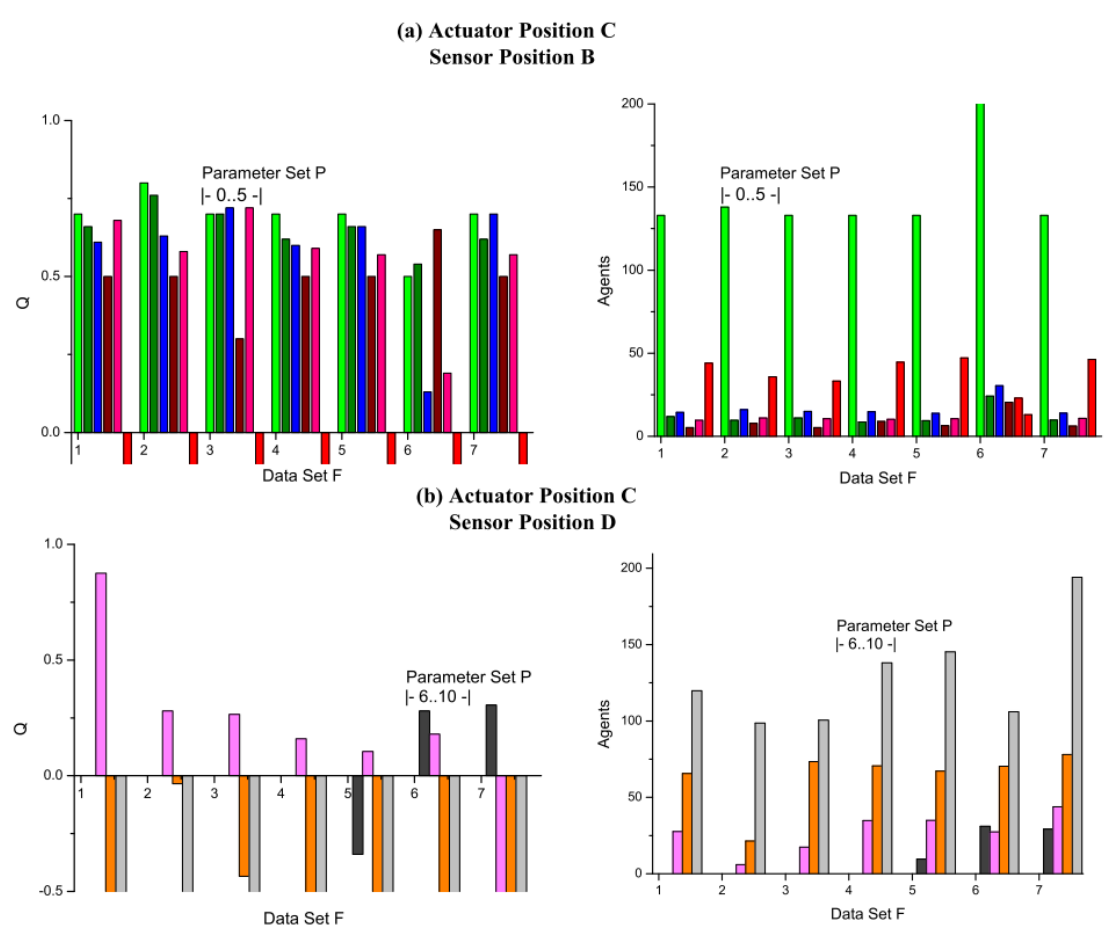
Figure 5. Analysis results showing quality Q ( left ) and agent population plots ( right ) of the ROI detection with different signal data sets F = {1, 2, 3, 4, 5, 6, 7}, Sensor ‐ Actuator configurations CB/CD, and parameter settings P = {0, 1, 2, 3, 4, 5}/{6, 7, 8, 9, 10} (different color bars). ( a ) Actuator pos. C (except F6: D), Sensor pos. B (except F6: E), error weight k = 10; ( b ) Actuator pos. C (except F6: D), Sensor pos. D (except F6: C), error weight k =